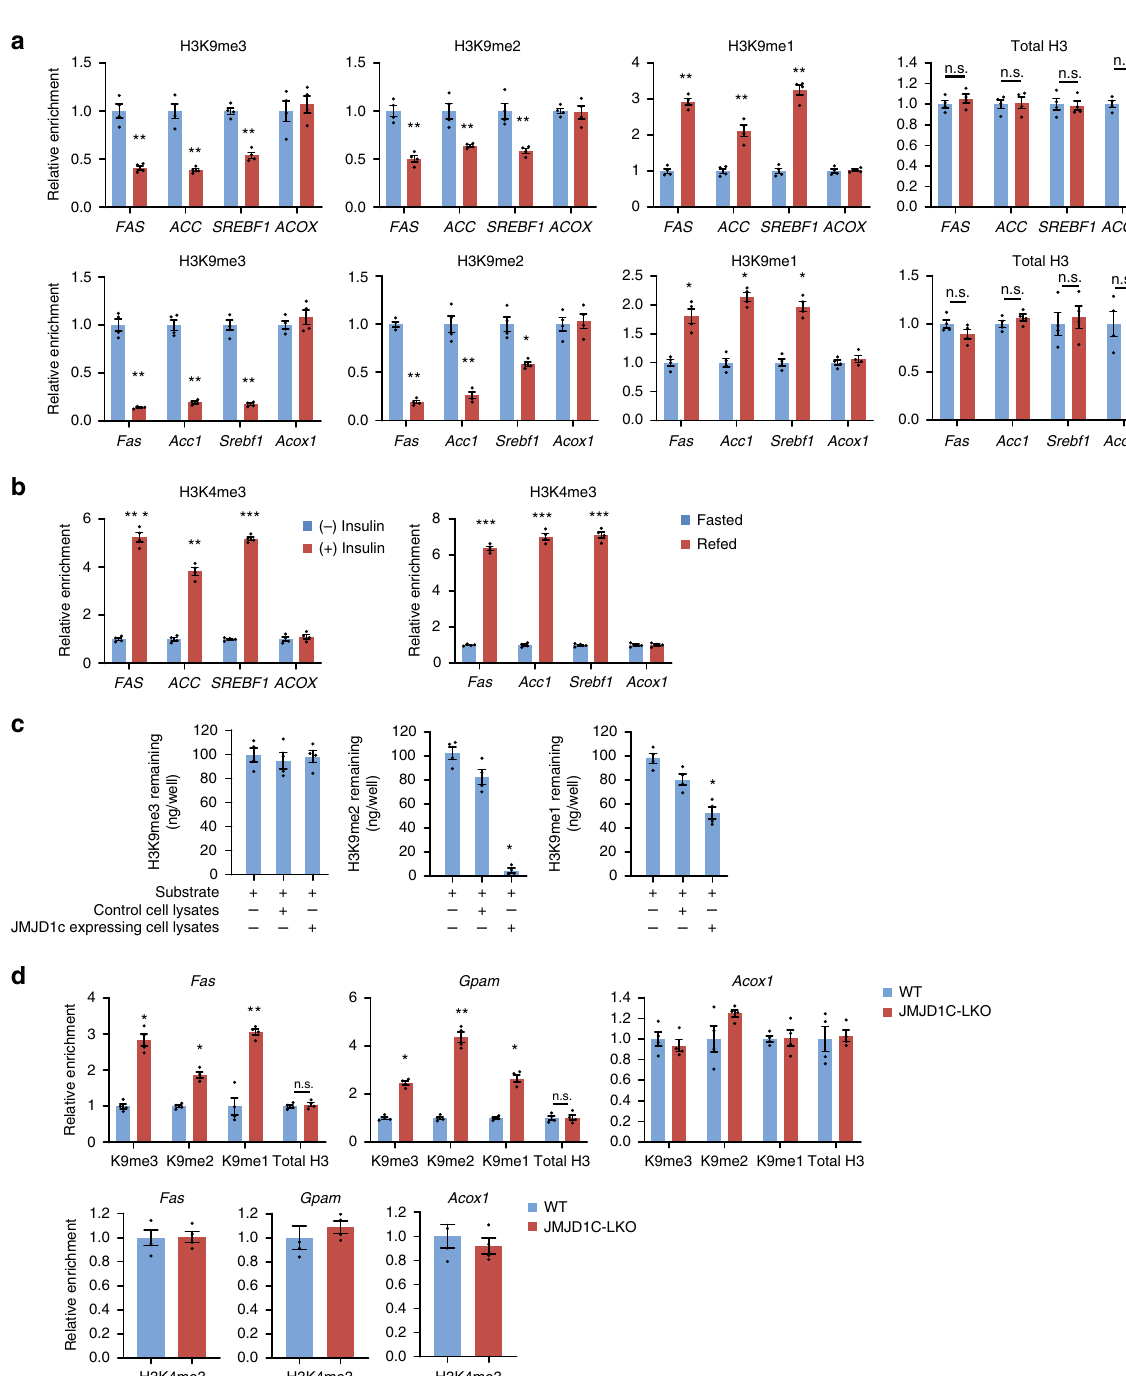
Fig. 4 Enrichment of H3K9me2 is decreased on lipogenic promoters by feeding/insulin. a ChIP for enrichment of H3K9me3, H3K9me2, and H3K9me1 on FAS , ACC , and SREBF1 promoters in HepG2 cells with or without insulin treatment (top) n = 4 wells of cells per group. ChIP for enrichment of H3K9me3, H3K9me2, and H3K9me1 on lipogenic gene promoters in livers from fasted and fed mice (bottom) n = 4 per group. b ChIP for enrichment of H3K4me3 on lipogenic promoters upon insulin/feeding, n = 4 per group. c In vitro demethylation assays using individual H3K9me3, H3K9me2, or H3K9me1 peptides, along with control or JMJD1C expressing HepG2 cell lysates, n = 4 dishes of cells per group. d ChIP for enrichment of H3K9me3, H3K9me2, and H3K9me1 on Fas and Gpam promoters in livers from JMJD1C-LKO and their WT littermates on chow diet in the fed state. n = 8 per group. Data are expressed as means ± SEM. * P < 0.05, ** P < 0.01, determined by two-tailed t -test. Source data are provided as a source data fi LKO mice (Fig. 5g, left). Genes in various metabolic processes We next compared genes downregulated in the JMJD1C-LKO were also detected to be upregulated in the JMJD1C-LKO mice mice to those detected in refed WT mice by ATAC-seq. We (Fig. 5g, left). The most signi fi cantly affected was glycolysis, with reasoned that if these genes were directly downregulated due to phosphofructokinase, aldolase, and phosphoglycerate kinase, depletion of Jmjd1c , they should coincide with genes detected in among others, being upregulated in the JMJD1C-LKO livers. the refed WT by ATAC-seq. We detected similar processes